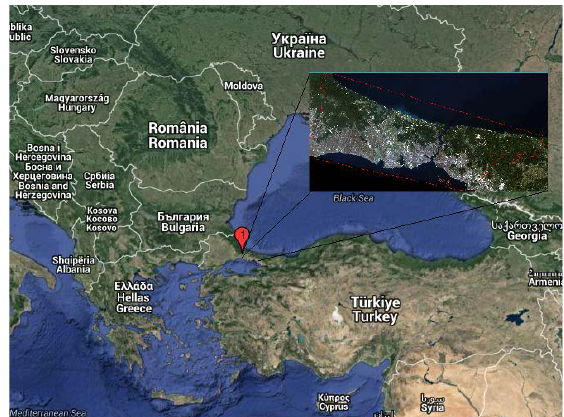
Figure 1. İstanbul is ch osen as the study area.[7] The population of Istanbul was 3 million the 1970s,